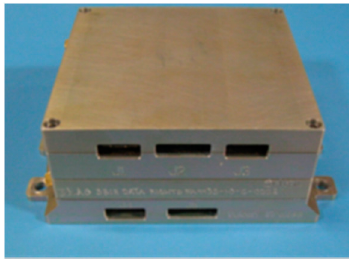
Figure 3. ASTERIA radio, courtesy of Vulcan Wireless Inc.